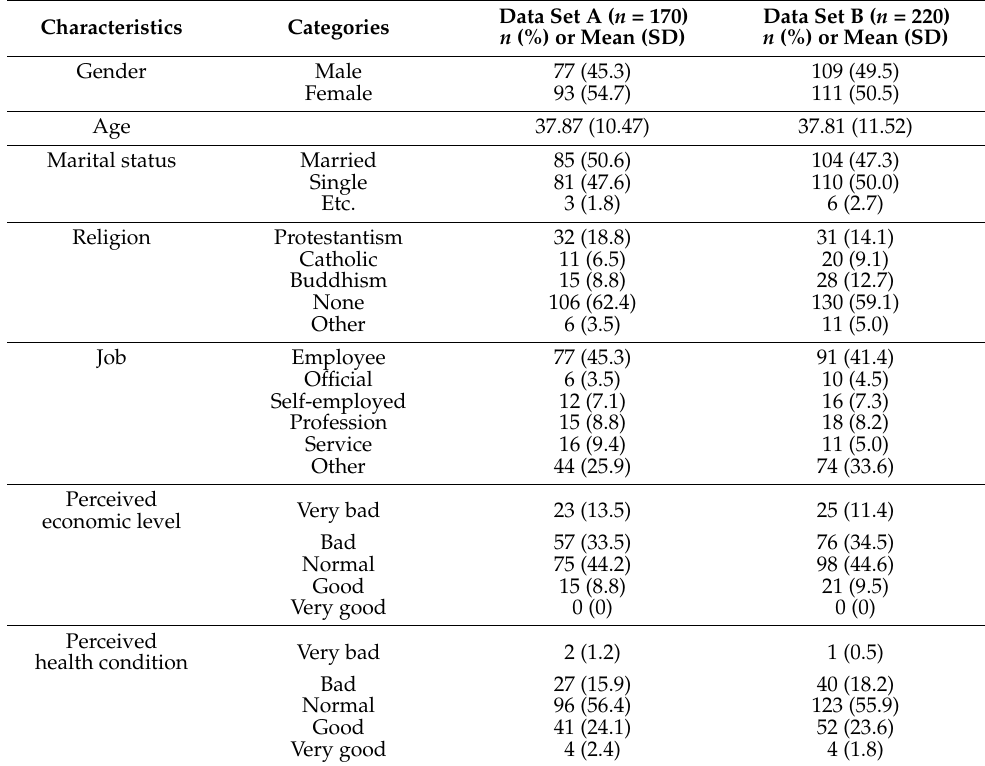
Table 2. General characteristics of the study